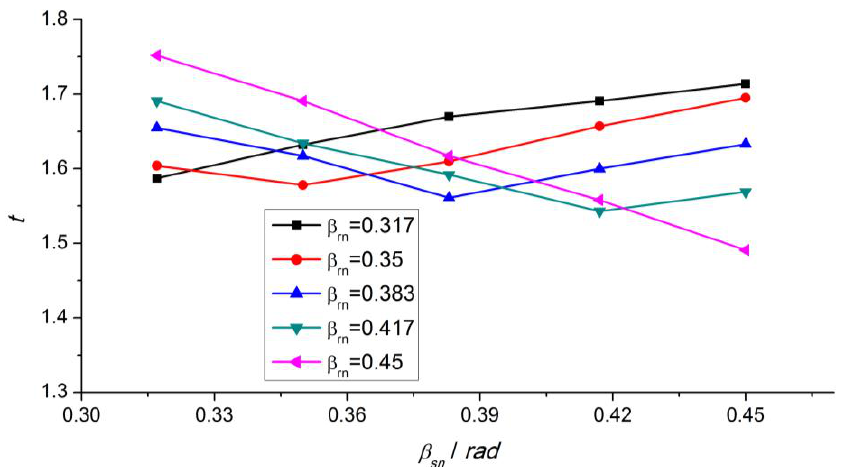
Figure 25. The curves of torque ripple coefficient under different β sn and β rn